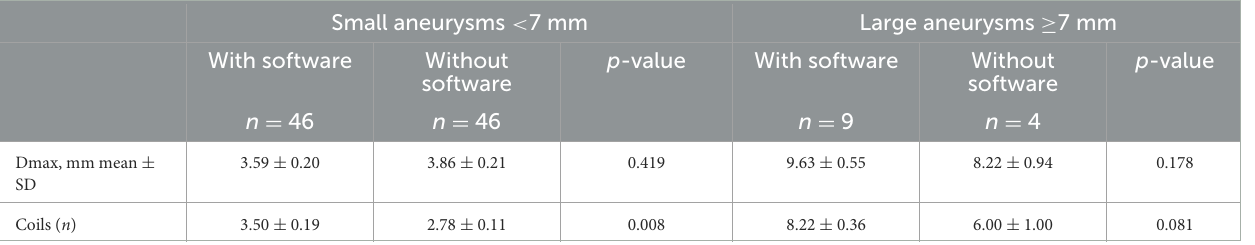
TABLE 2 Number of coils used.